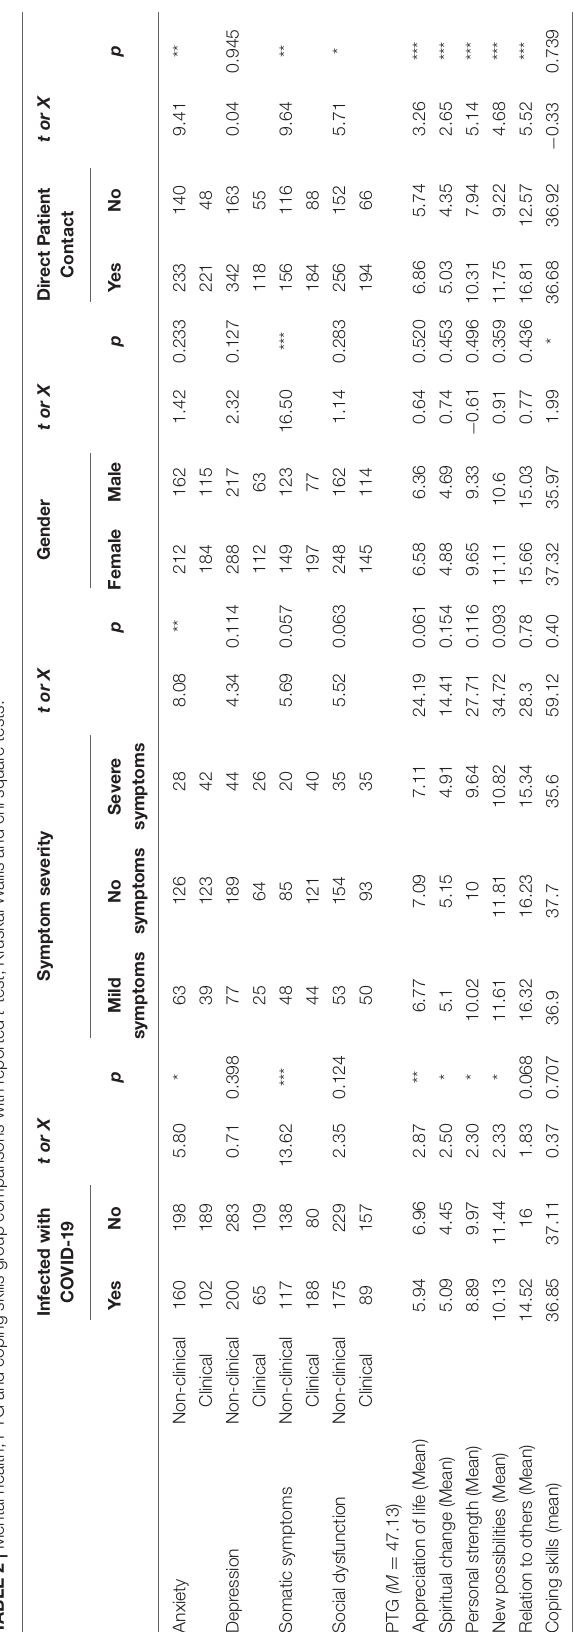
Anxiety Depression Somatic Social ( n ) ( n ) symptoms ( n ) dysfunction ( n )